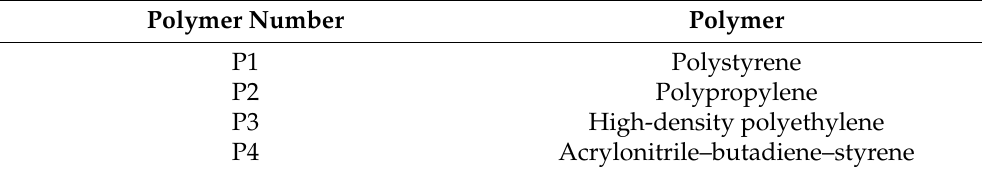
Figure 2. Teas graph of various plastics and solvents according to the hydrogen bonding, dipole–diploe force, and the dispersion force, respectively. Lines show the boundary conditions for three models including the Hansen solubility sphere, the Flory–Huggins solubility, and the Hildebrand solubility. Table 4. List of polymer numbers relevant to Figure